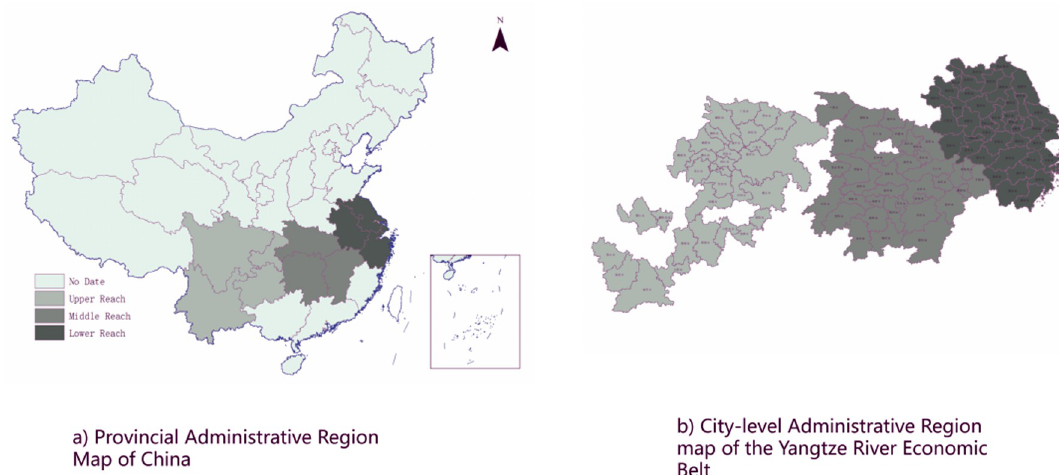
Fig 1. Classification of the prefecture-level cities in the Yangtze Econogic